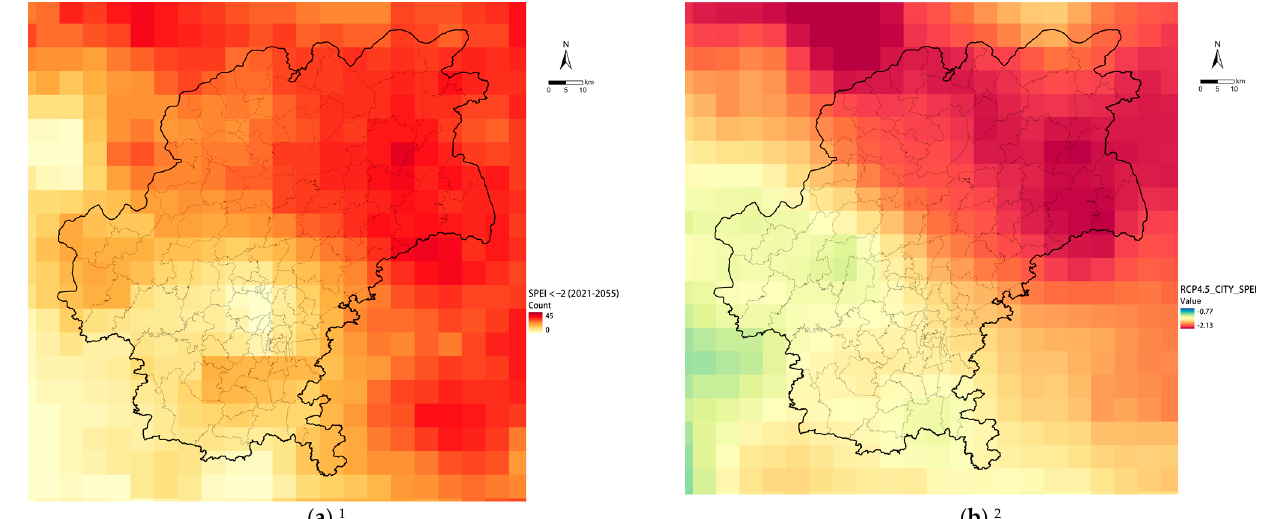
Figure 9. Guiyang agrometeorological drought risk analysis by monthly SPEI under RCP4.5. ( a ) Extreme dry (drought) months count from 2021–2055; ( b ) SPEI distribution in a drought event in 2050s. 1,2 Included some area of Anshun (a neighbor prefecture-level city) demanded by the objective of actual planning process.